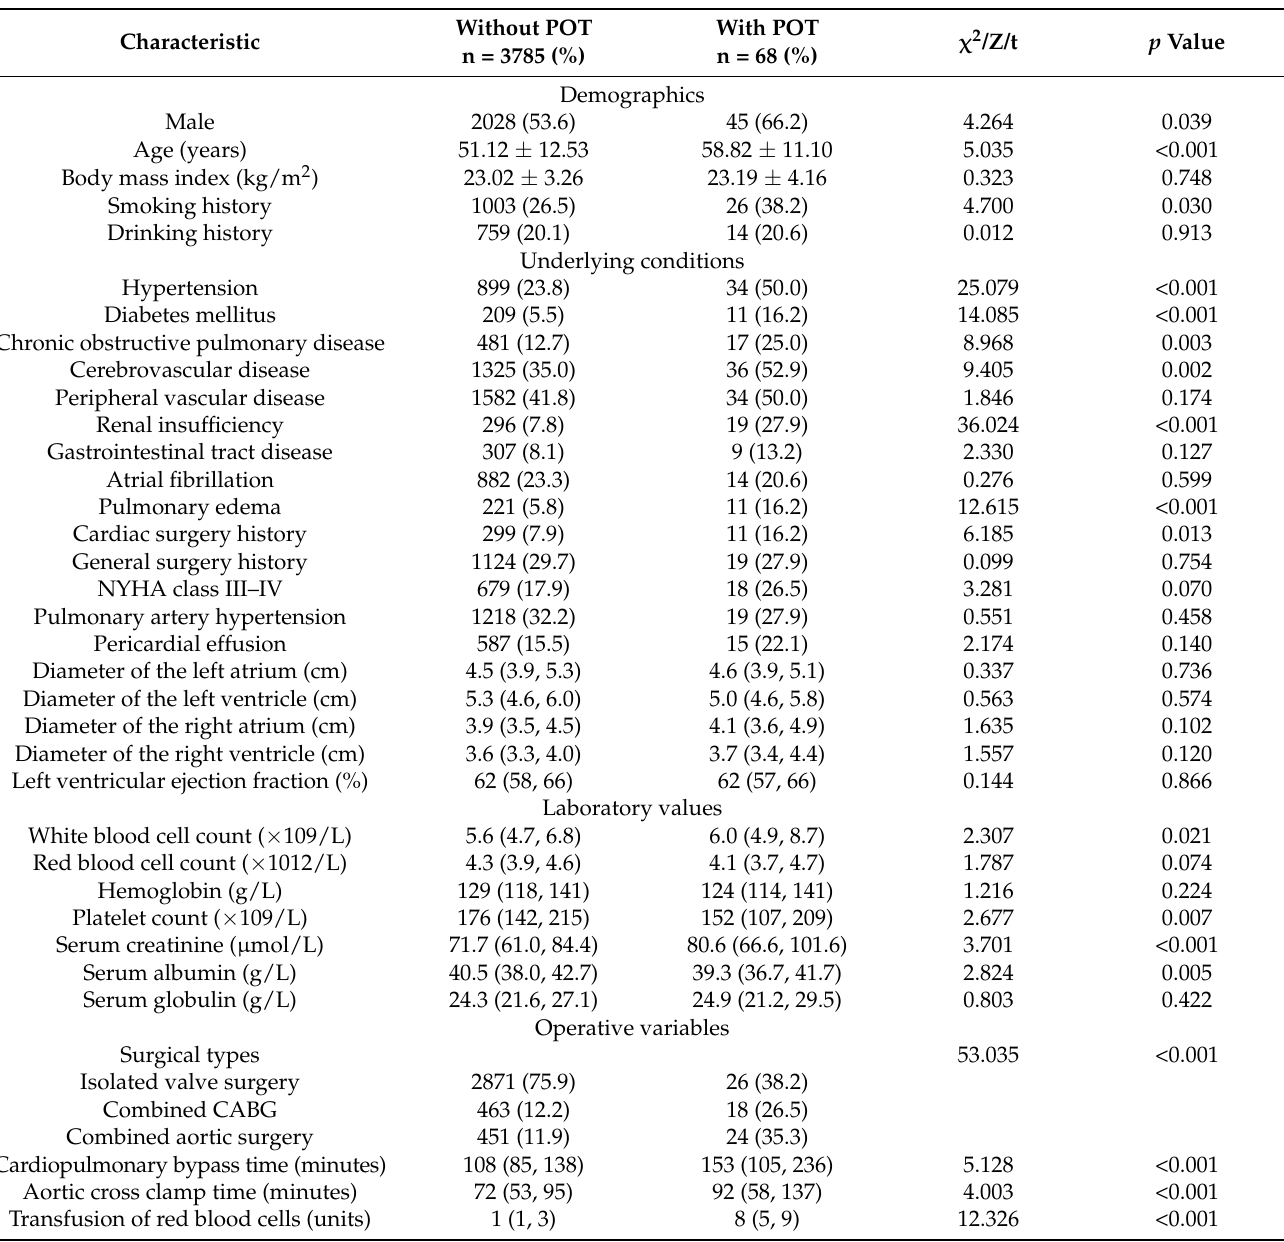
Table 1. Univariate analysis of possible risk factors for POTs after